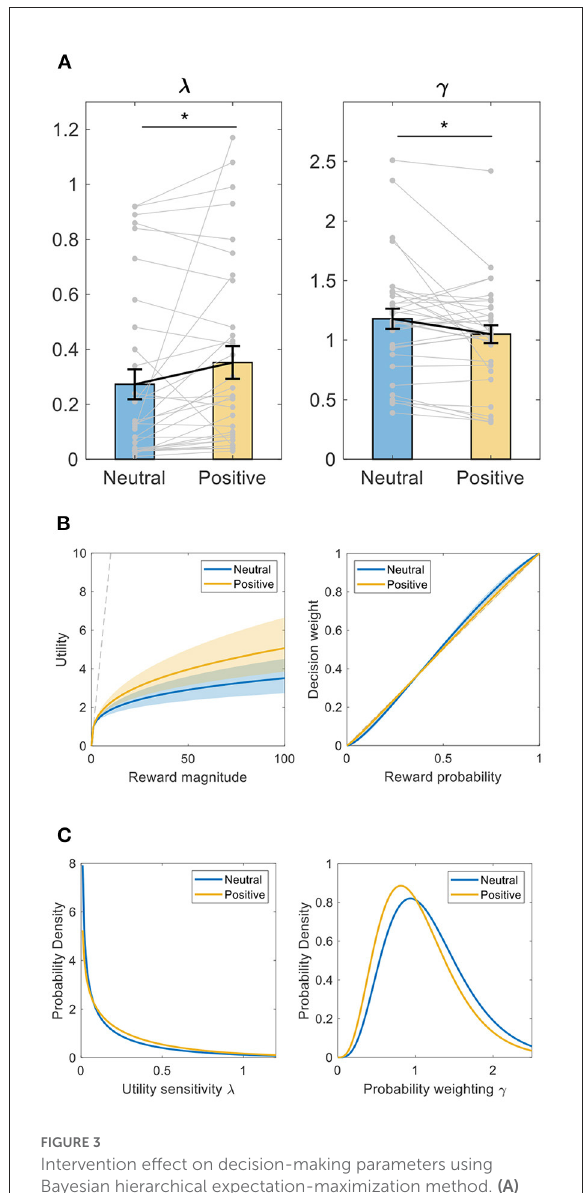
FIGURE3 Intervention effect on decision-making parameters using Bayesian hierarchical expectation-maximization method. (A) utility sensitivity λ and probability weighting γ . * p < 0.05, Wilcoxon signed-rank test. Data shown as mean ± SE. (B) illustration of the utility and probability weighting function changes after positive memory retrieval, plot with the mean ± SE of each parameter. Left panel, utility (u) as a function of reward magnitude (x). Right panel: decision weight (w) as a function of objective probability ( p ). The dashed line represents linear utility or probability weighting. (C) the estimated population prior distributions for utility sensitivity λ and probability weighting γ